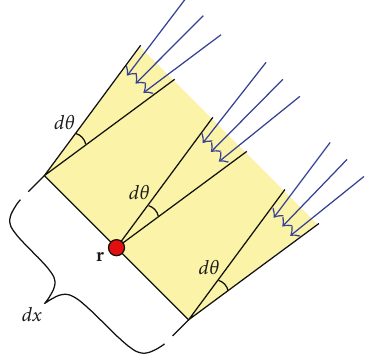
Figure 1: Angular flux ϕ ( r , θ ) is the rate of packets crossing a small perpendicular line segment dx from angle ( θ , θ + dθ ) divided by dθ · dx at the limit dθ , dx → 0.